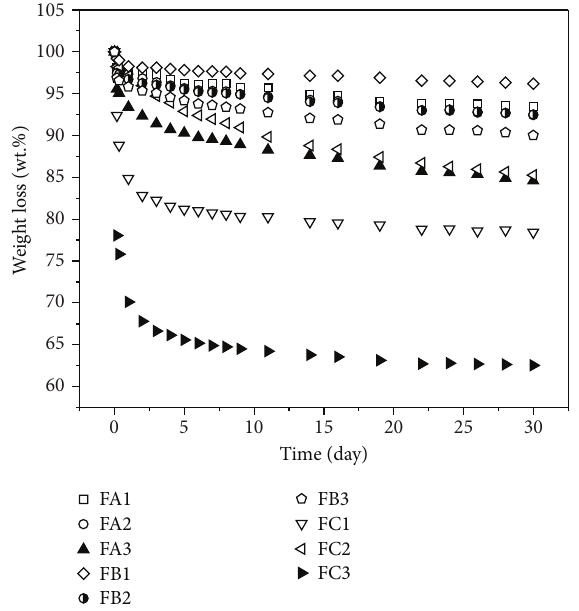
Figure 4: Comparison of heat resistance of the boron-modified and unmodified foams on the basis of their 30-day annealing at 150 ∘ C.